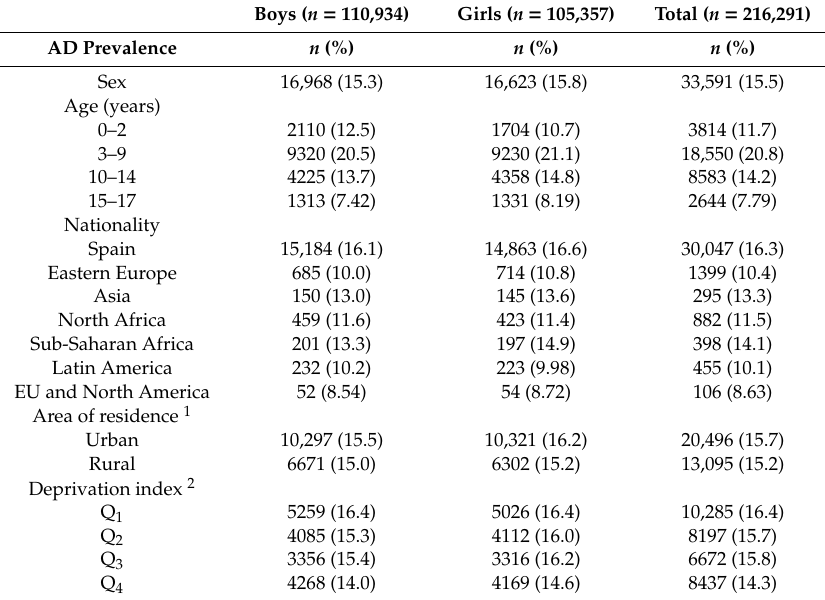
Table 1. Frequency and prevalence (%) of atopic dermatitis (AD) in children of the EpiChron Cohort aged 0–17 years in 2015 according to sex, age, nationality, area of residence and deprivation index. EU—European Union.